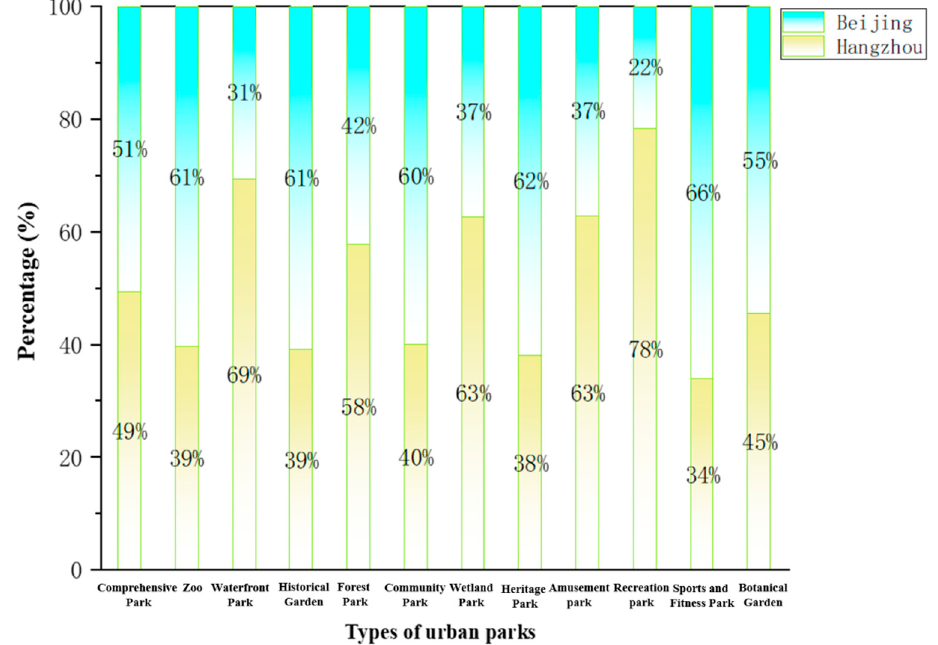
Figure 18. Comparison of 12 types of urban parks in Beijing and Hangzhou.